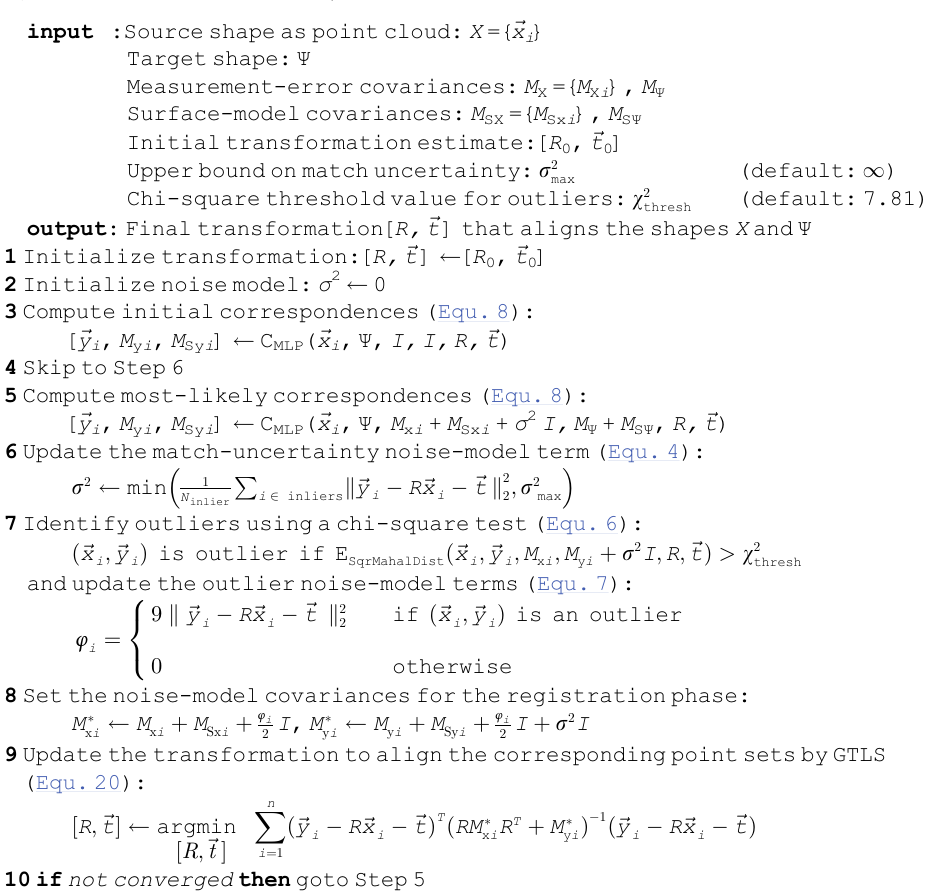
Algorithm 2. Iterative Most-Likely Point